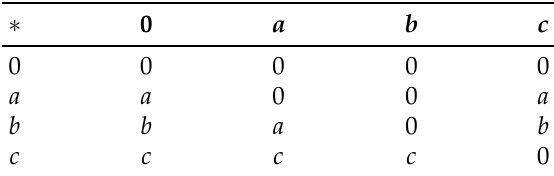
Table 4. Cayley table for the binary operation “ ∗